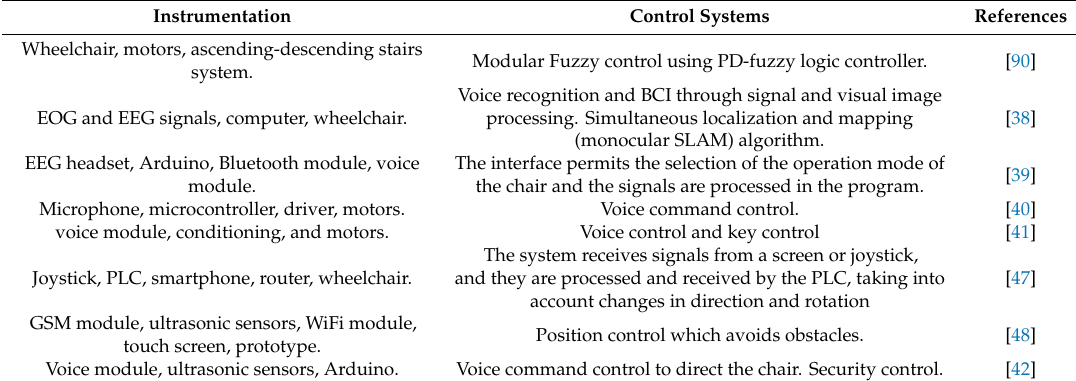
Table 7. Other types of instrumentation and control